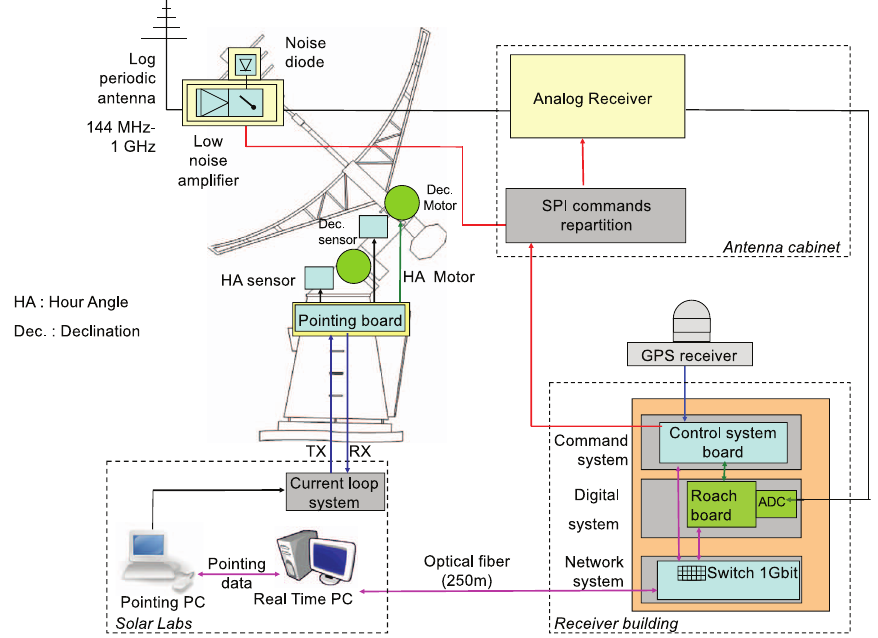
Fig. 1. ORFEES radio spectrograph: antenna, receiver (analog, digital), command system and data acquisition system.